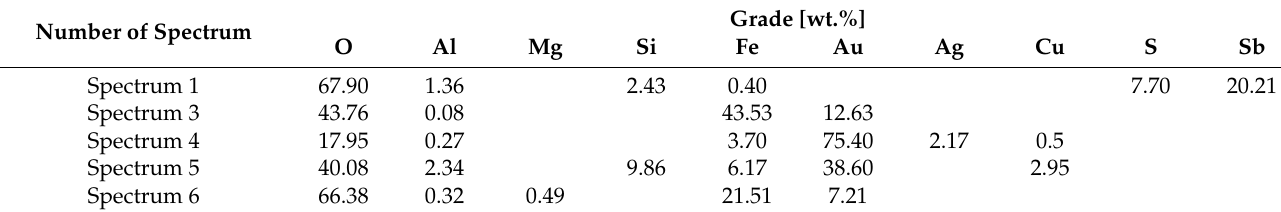
Figure 20. Results of the investigation of carbonaceous concentrate. Table 15. Elemental composition of the spectrum for the samples presented in Figures